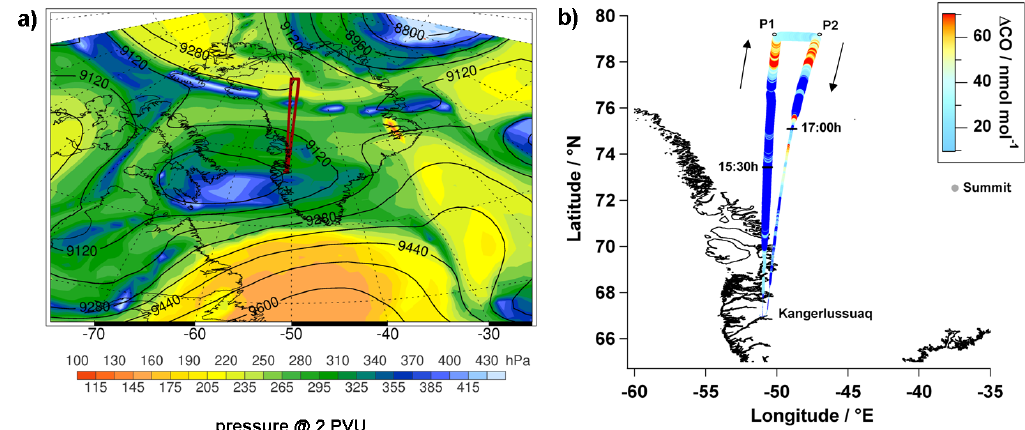
Fig. 1. (a) Flight path of the DLR Falcon on 10 July 2008 between ∼ 14:30UTC and 18:30UTC (red line) superimposed on ECMWF analysis data at 18:00UTC of pressure (colour shaded, hPa) at the 2PVU (dynamical tropopause) surface and geopotential height at 300hPa (black lines, m). (b) Flight path, colour-coded by 1 CO above altitude-dependent background values as derived from all GRACE data. Areas with 1 CO < 10nmolmol − 1 are shown in dark blue. North of approx. 77.5 ◦ N, an air mass with enhanced CO mixing ratios was entered by the Falcon, both on the outbound and return leg at a constant flight level (11.3km). The thickness of the line indicates the altitude (larger markers represent higher altitudes). For more details see